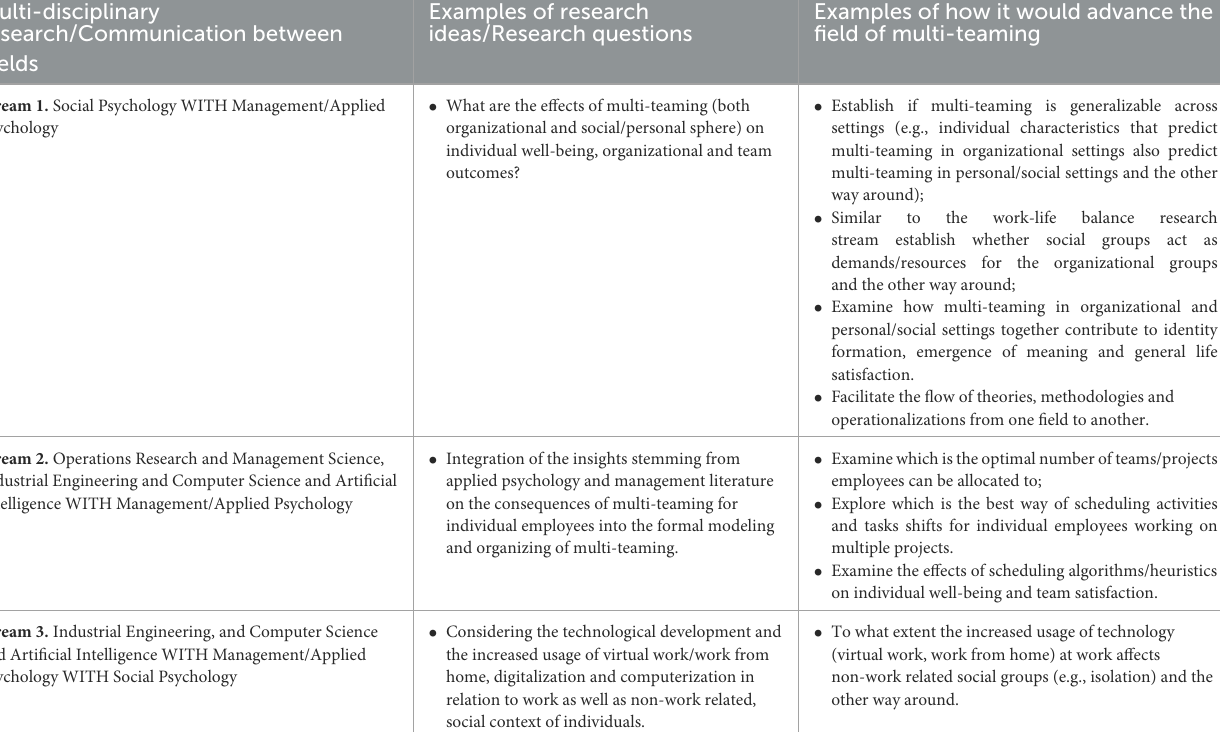
TABLE 3 Examples of (multi-disciplinary) directions for future research. Multi-disciplinary research/Communication